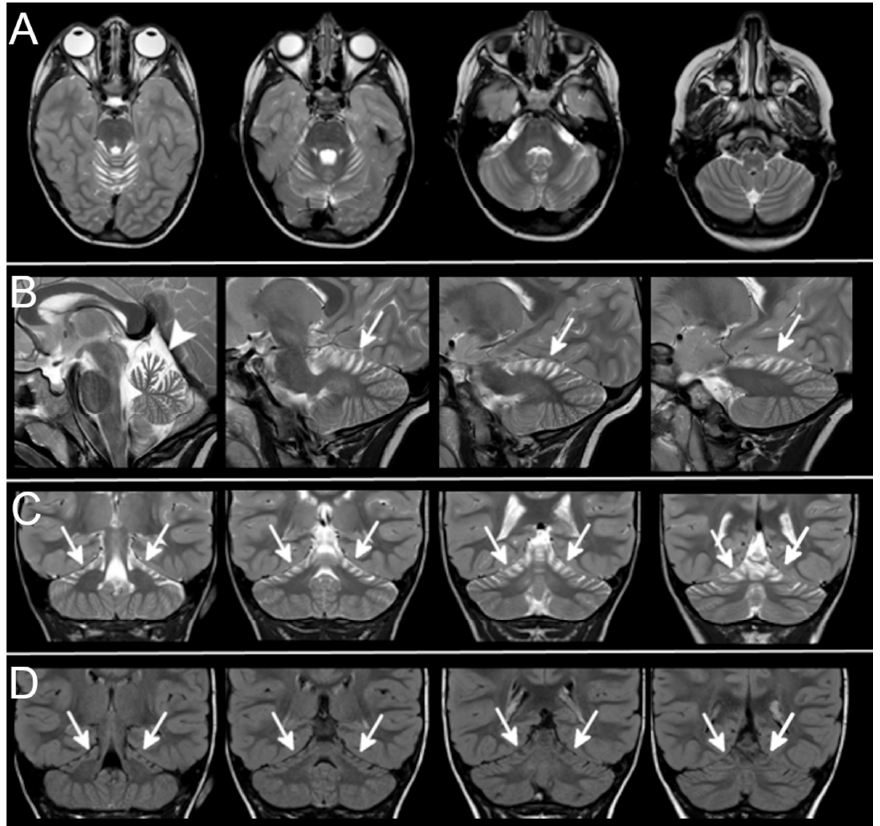
Figure 2. Superior cerebellar atrophy. Axial ( A ), sagittal ( B ), coronal ( C ), T2-weighted and coronal FLAIR ( D ) sections show the typical pattern of superior cerebellar atrophy (Patient 18-Table 1). The superior part of cerebellar hemispheres (arrows) and vermis (arrowhead) show marked atrophy with enlarged cortical CSF spaces. No cerebellar signal alterations can be detected on T2-weighted and FLAIR sections. The inferior part of the cerebellum is not atrophic and looks